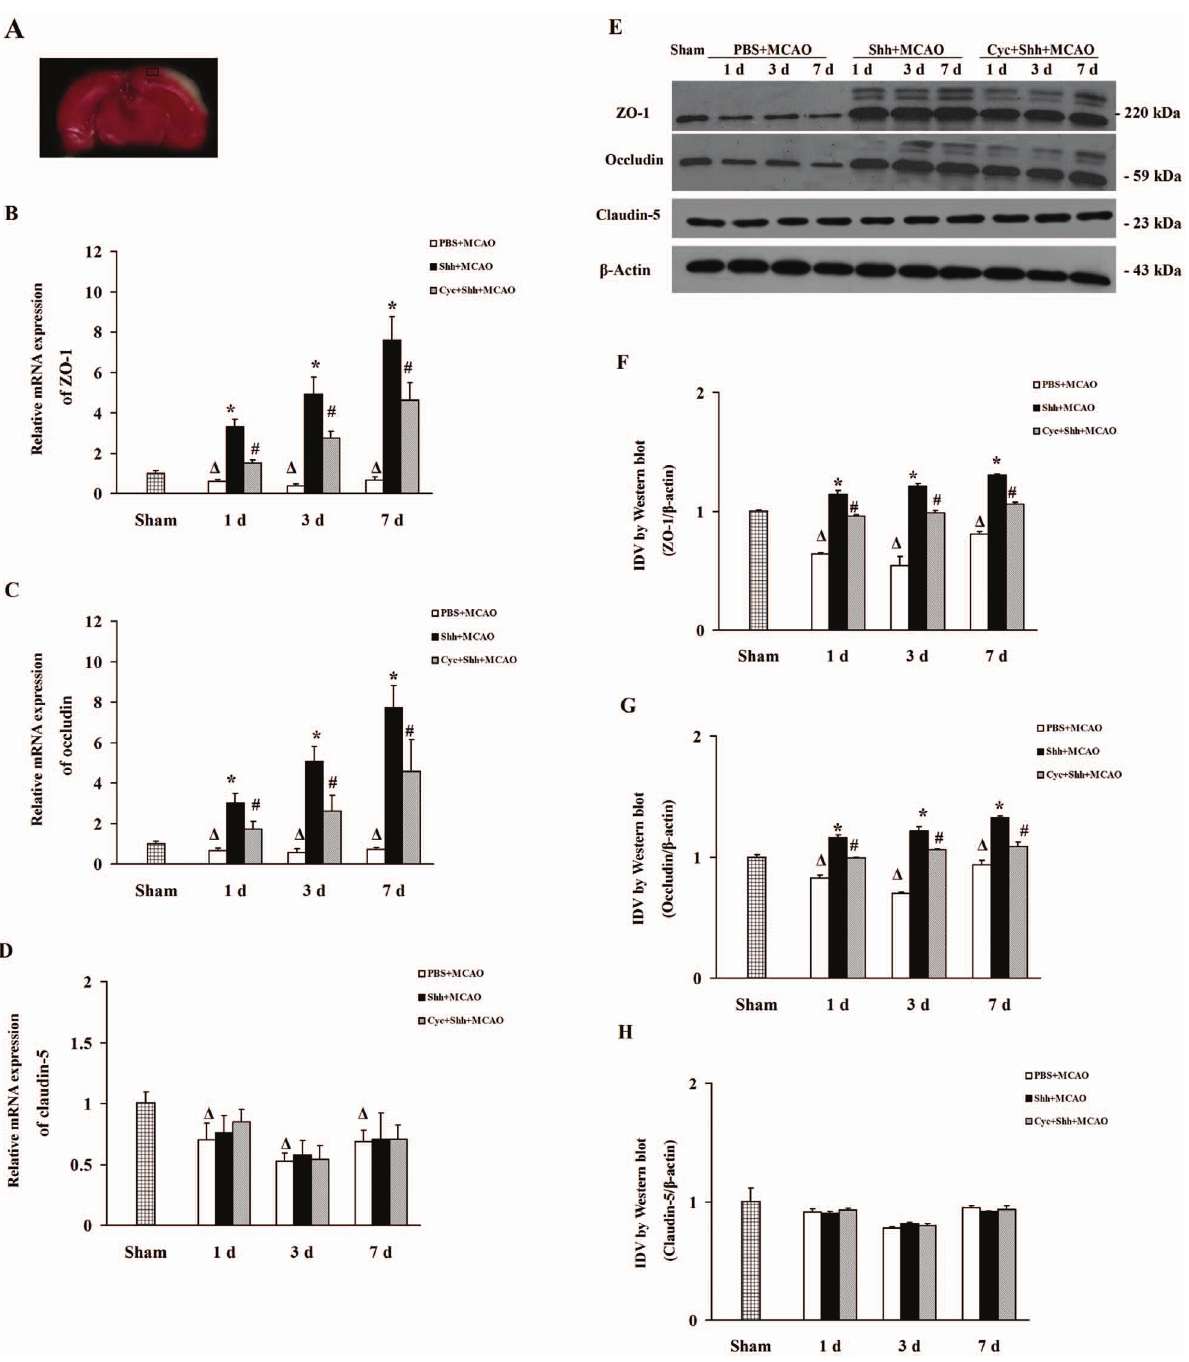
Figure 3. Shh Treatment Upregulates the Expression of ZO-1 and Occludin In the Brain Tissue of Ischemic Rats. After establishment of pMCAO, rats were intracerebroventricularly injected 3 m L of PBS, 3 m g of Shh, and Shh (3 m g) plus cyclopamine (Cyc, 30 m g). The brain slices were staining by using a 2% TTC solution, and we selected the ischemic penumbra for the ensuing experiments. The expression of ZO-1, occludin and claudin-5 from ischemic penumbra was detected by Western blotting and real-time RT-PCR at indicated time points (1 d, 3 d, and 7 d). (A) Representative photographs of TTC stained brain slice. Brain samples were selected from ischemic penumbra. (B-D) The mRNA levels of ZO-1 (B), occludin (C) and claudin-5 (D). (E) Representative photographs of Western Blotting bands. (F-G) The IDV of ZO-1, occludin, and claudin-5. Grouping was the same as above. D P , 0.01 vs. the Sham group, * P , 0.01 vs. the PBS group at the same time points, # P , 0.01 vs. the Shh group at the same time points. Each experiment repeated three times (n=6, each